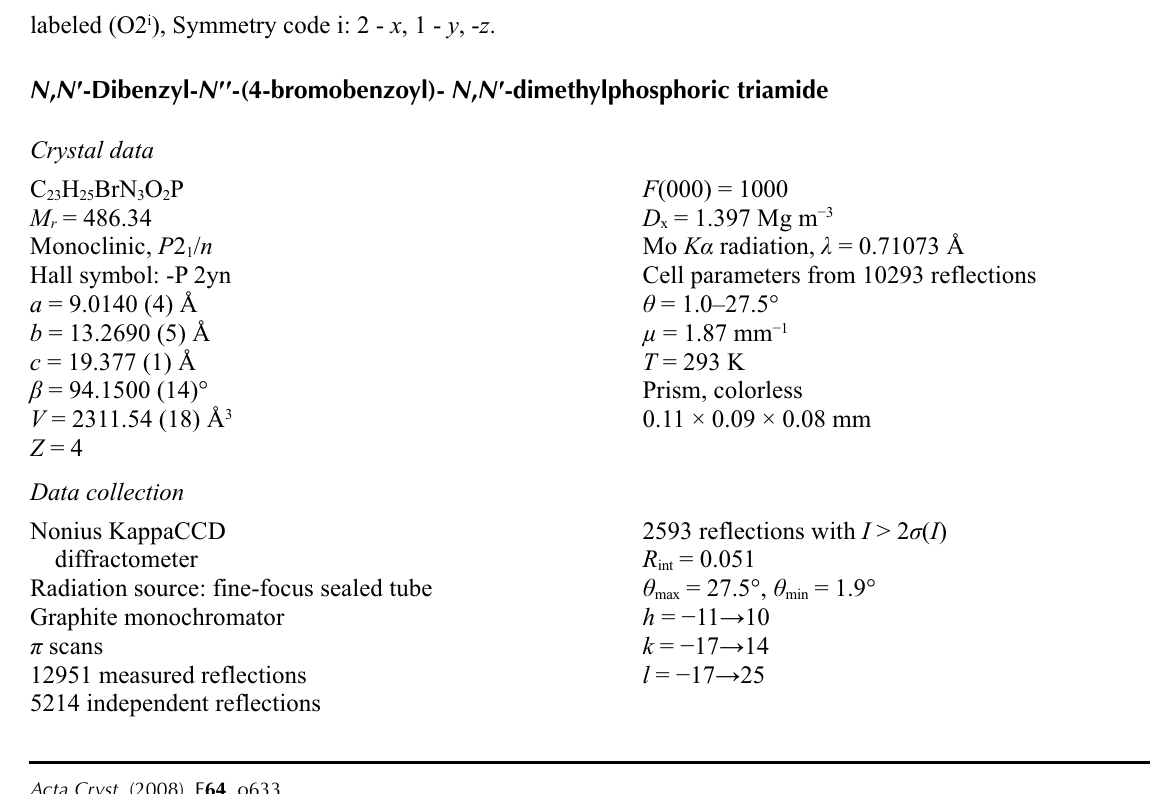
Representation of the hydrogen bonds in the structure of (I). For clarity, only the O2 atom in the second molecule is labeled (O2 i ), Symmetry code i: 2 - x , 1 - y , - z